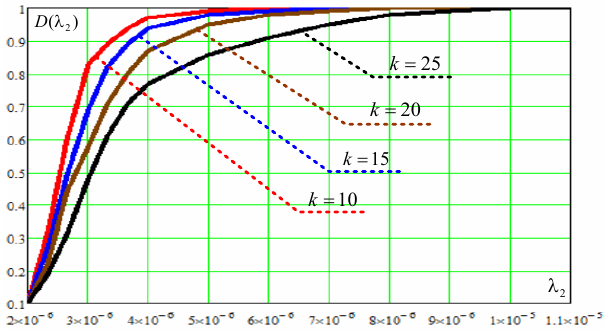
Fig. 5. The operating characteristics of changepoint